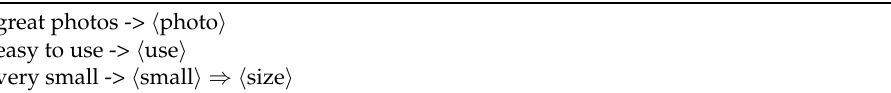
Table 2. The pros in Table 1 can be separated into three